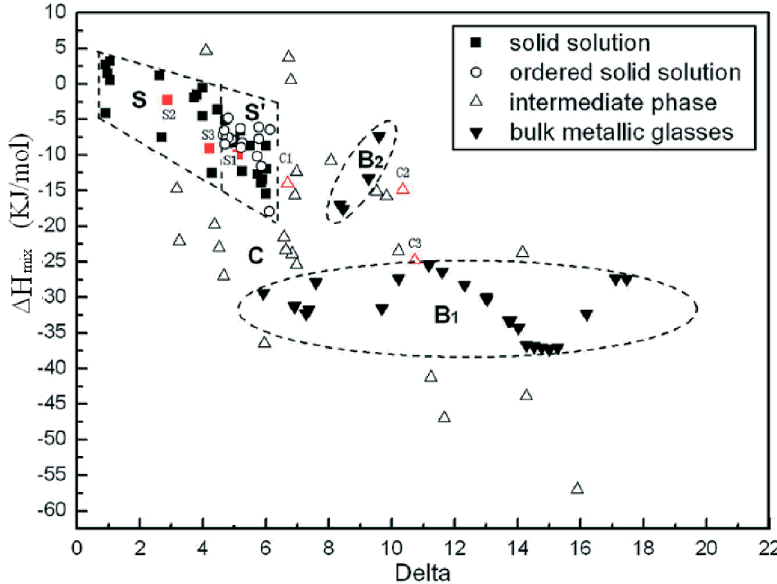
Figure 4. Microstructures of MPE alloys and Bulk Metallic Glasses as a function of enthalpy of mixing and atomic size difference (this figure is from Reference [17]).